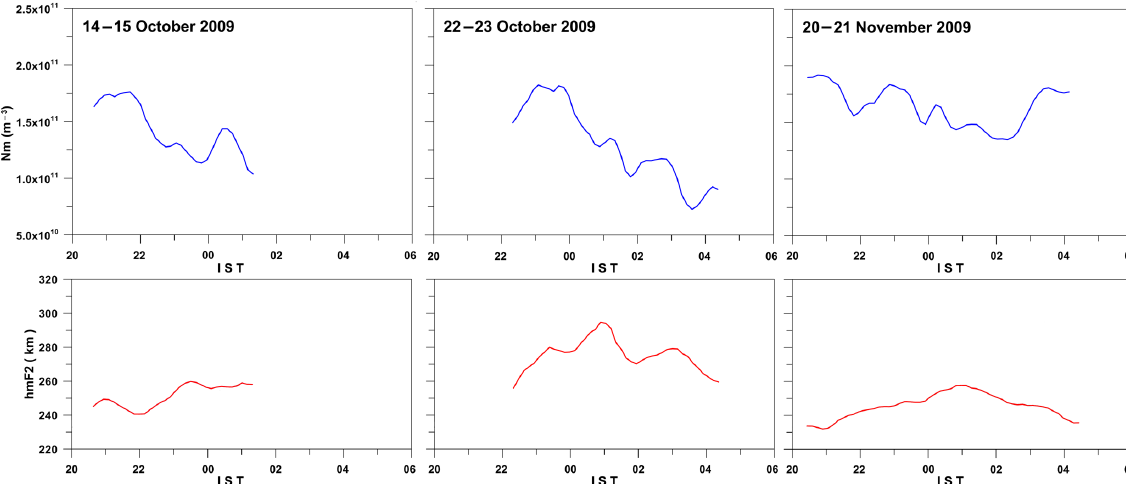
Figure 6. Nocturnal variation of derived Nm and hmF2 on 14 and 22 October (a slightly geomagnetically disturbed day) and 20 Novem- ber 2009